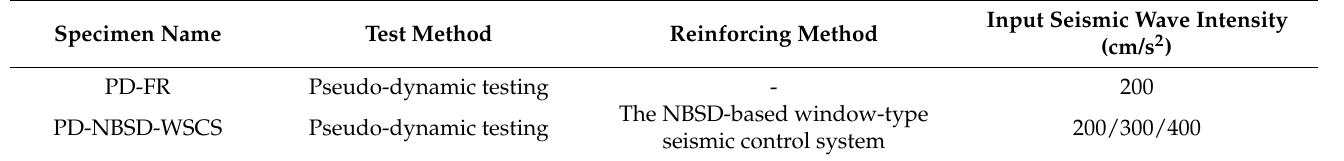
Table 8. Pseudo-dynamic testing specimens and the applied